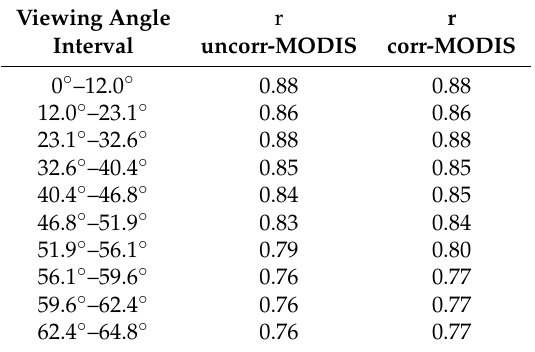
Table 2. The correlation coefficient (r) between (un)corrected MODIS/Aqua and VIIRS/Suomi-NPP 1 ◦ gridded-FRP collocated pairs, grouped according to the MODIS viewing angle. The data is from the year 2017.